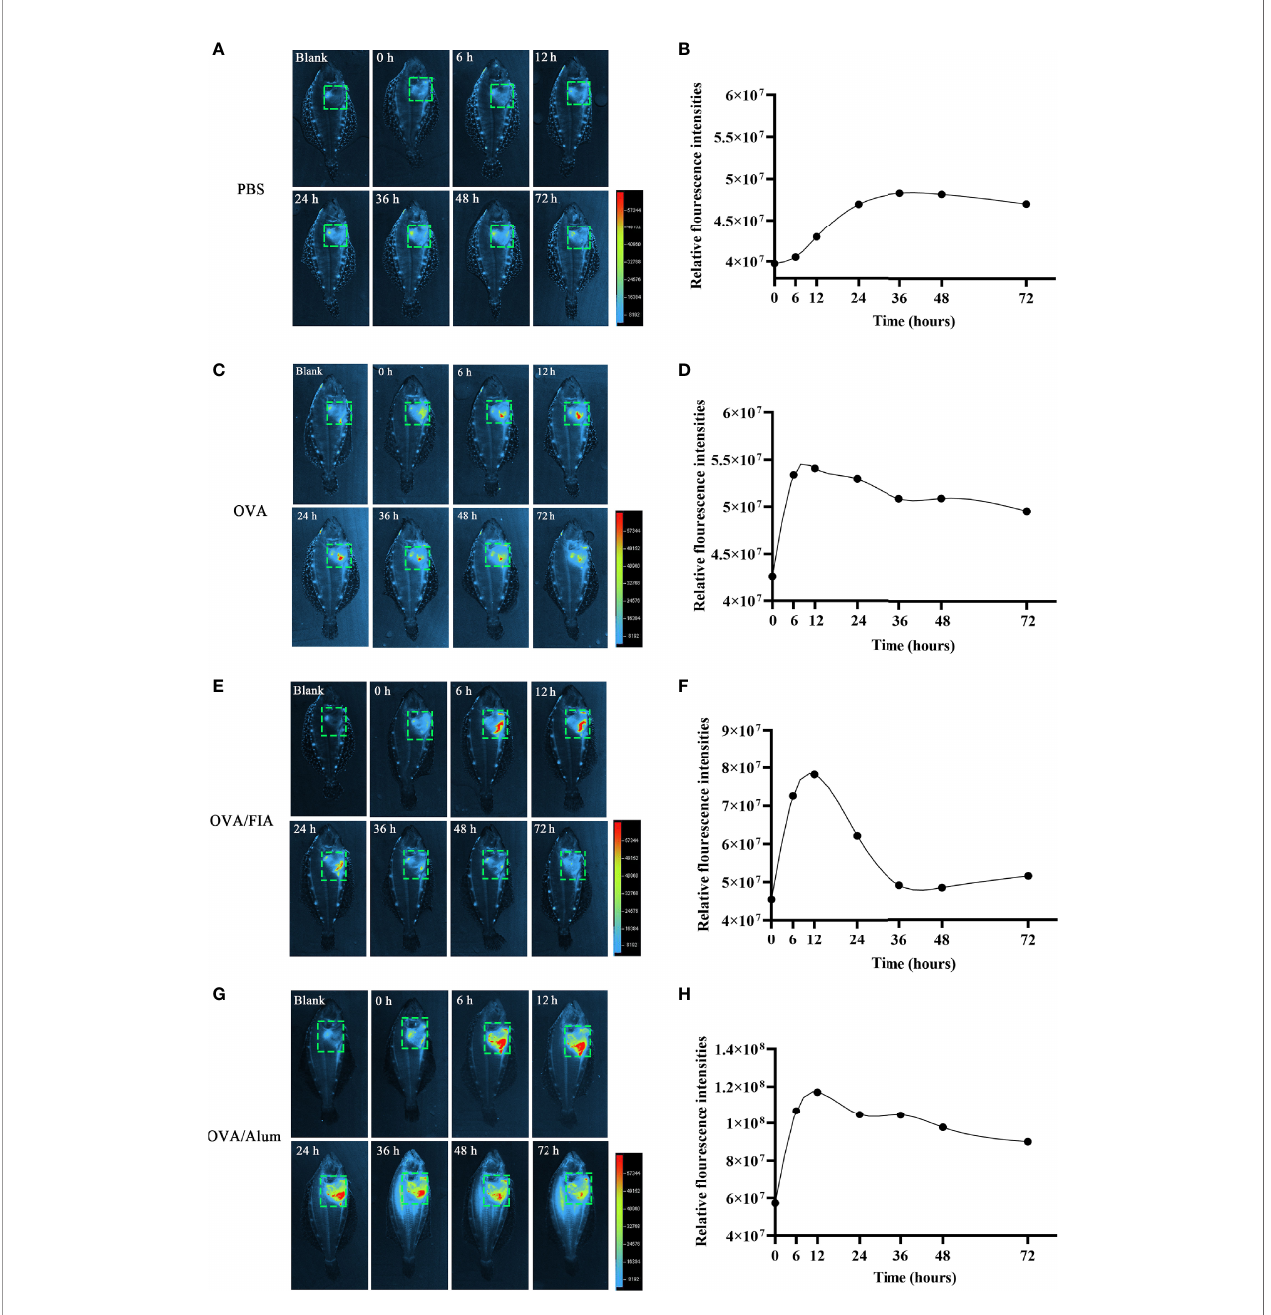
FIGURE 4 | Extracellular trap (ET) release post-intraperitoneal injected with antigen and mixture at different times in fl ounder. In vivo imaging of ETs timely released in fl ounder after phosphate-buffered saline (PBS) (A) , ovalbumin (OVA) (C) , OVA/FIA (E) , OVA/Alum, and (G) intraperitoneal injection. Quantitation of the signals emitted from fl ounder in the green squares after immunization with PBS (B) , OVA (D) , OVA/FIA (F) , and OVA/Alum (H) . The fl uorescence intensity indicates the quantity of the extracellular DNA dyed by Sytox Green. The scale represents the number of photons per second/per cm 2 . These representative data are from the study of 10 independent fi